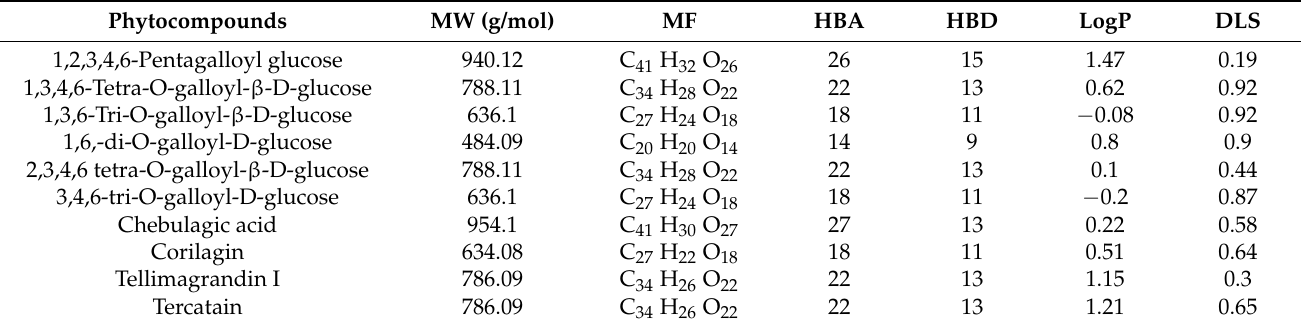
Figure 11. Stability of 1,2,3,4,6-Pentagalloyl glucose with HCV NS3/4A at 50 ns of simulation: ( a ) RMSD, ( b ) RMSF, ( c ) rGyr, and ( d – f ) residue-wise ligand–protein contacts. Table 5. Druglikeness characteristics of